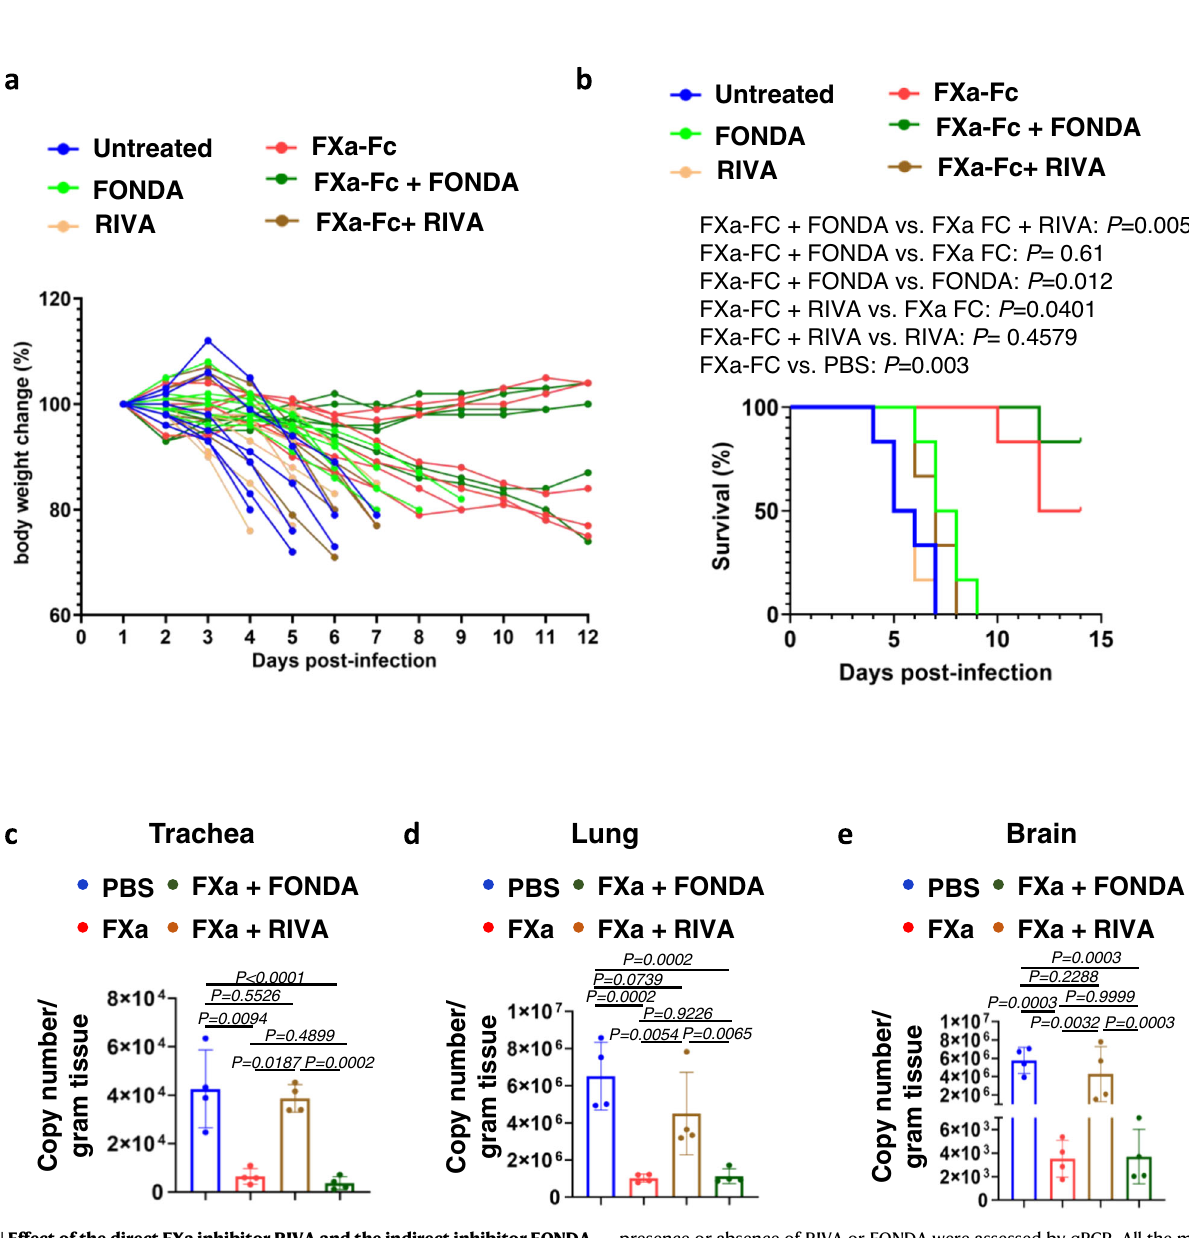
presence or absence of RIVA or FONDA were assessed by qPCR. All the mice were sacri fi cedonday5postinfection. N =4miceforeachgroup. c – e Dataarepresented as mean values ±SD. Statistical analyses were performed by one-way ANOVA models ( c – e ) or log-rank test ( b ).Copy number ( c – e ) was log 2 transformed before running statistical models. Source data are provided as a Source Data fi